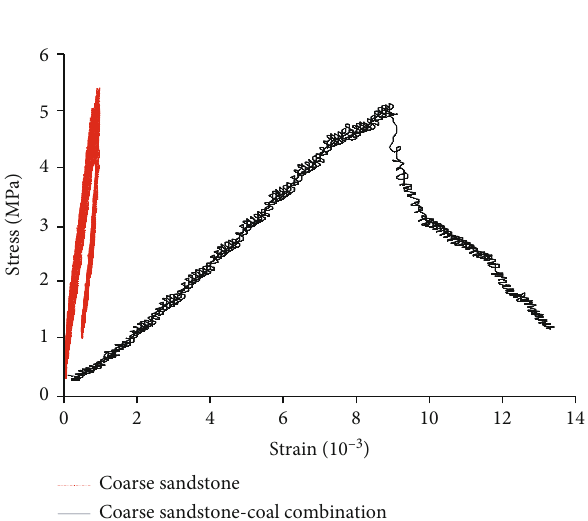
Figure 8: The stress-strain curve of the coarse sandstone-coal combination sample